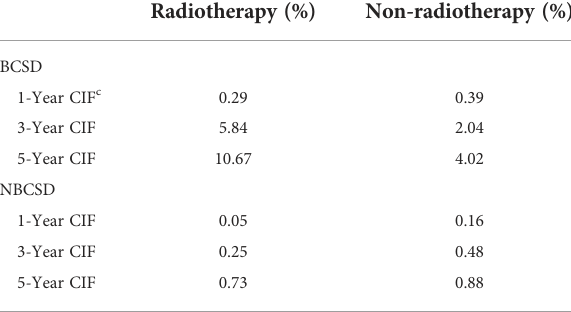
TABLE 2 The 1-, 3-, and 5-year cumulative incidence of BCSD a and NBCSD b .